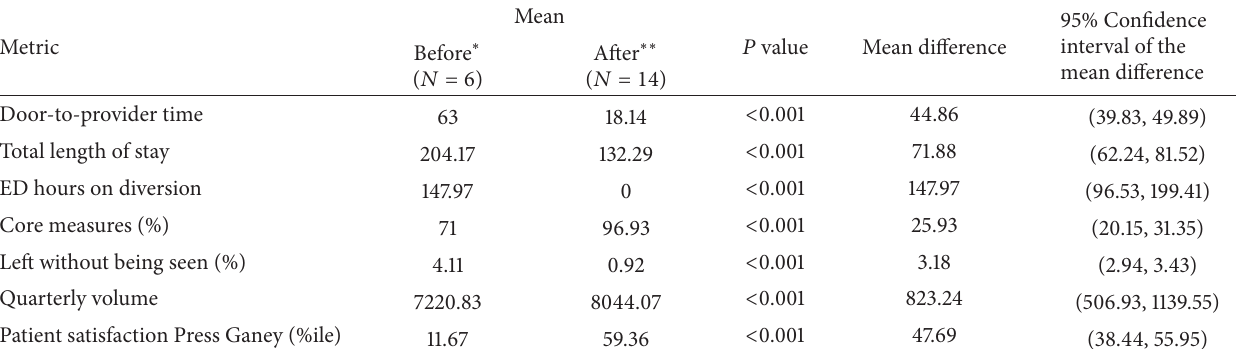
Table 2: Summary of results and statistical analysis.